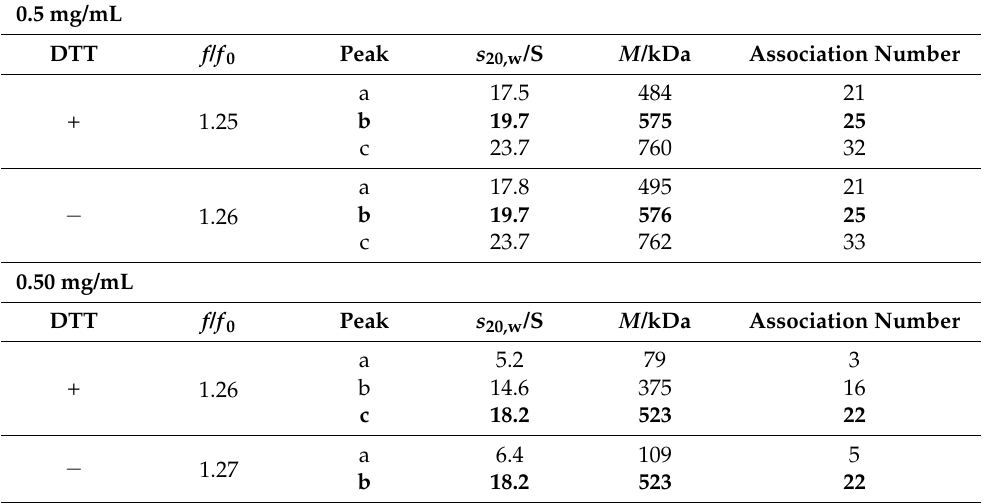
Table 4. Parameters of peak positions of c ( s 20,w ) in Figure 5B.